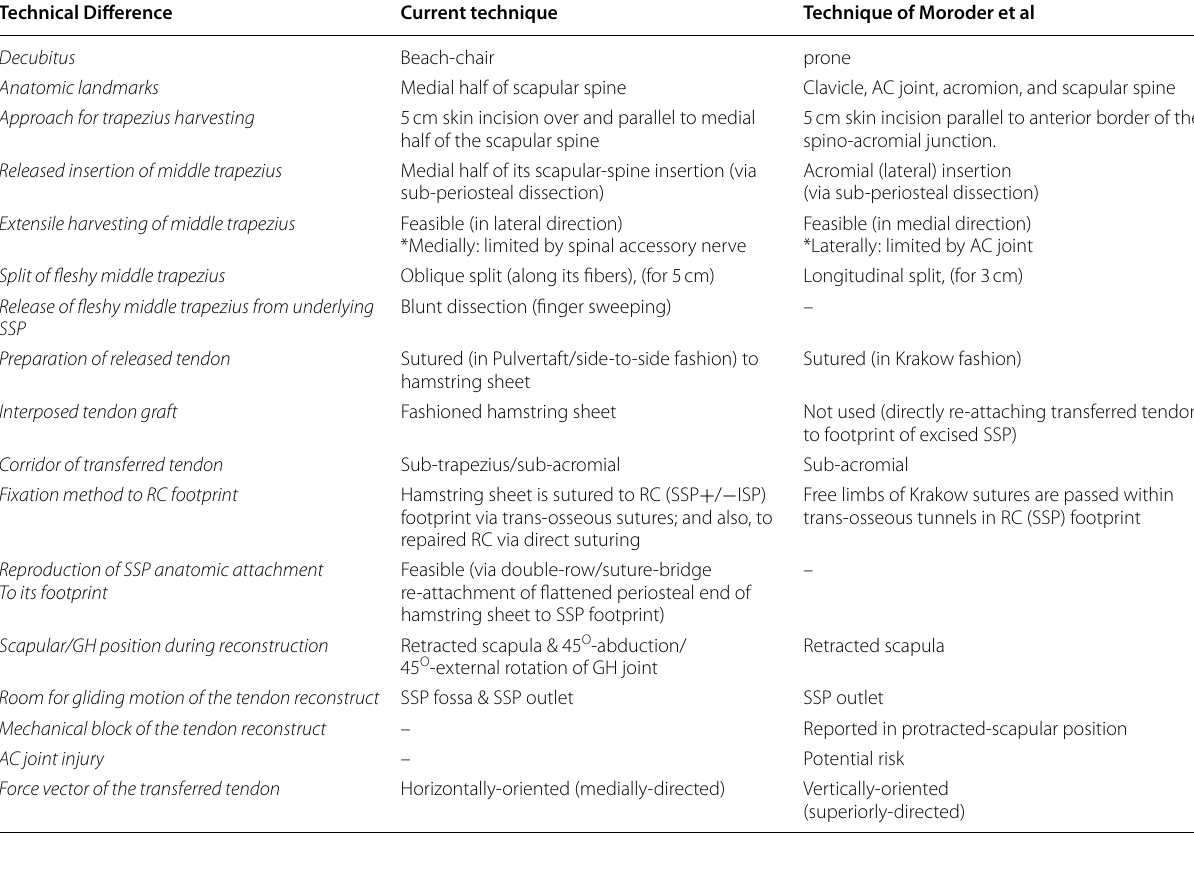
Table 3 Summarizes technical differences of currently reported technique of middle trapezius tendon transfer from that of Moroder et al.; AC acromio‑clavicular, GH gleno‑humeral, ISP infraspinatus, RC rotator cuff, SSP supraspinatus